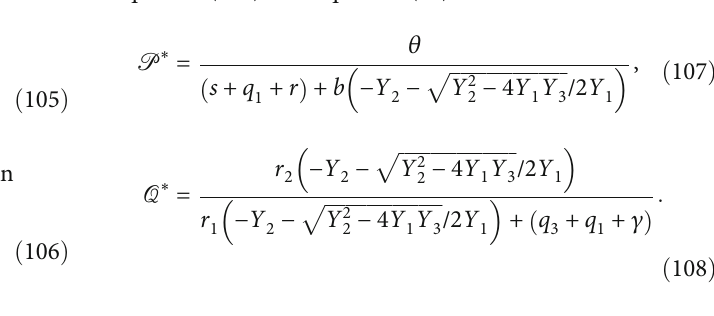
p ffiffiffiffiffiffiffiffiffiffiffiffiffiffiffiffiffiffiffiffiffiffiffi Y 2 − 4 Y Y 1 3 2